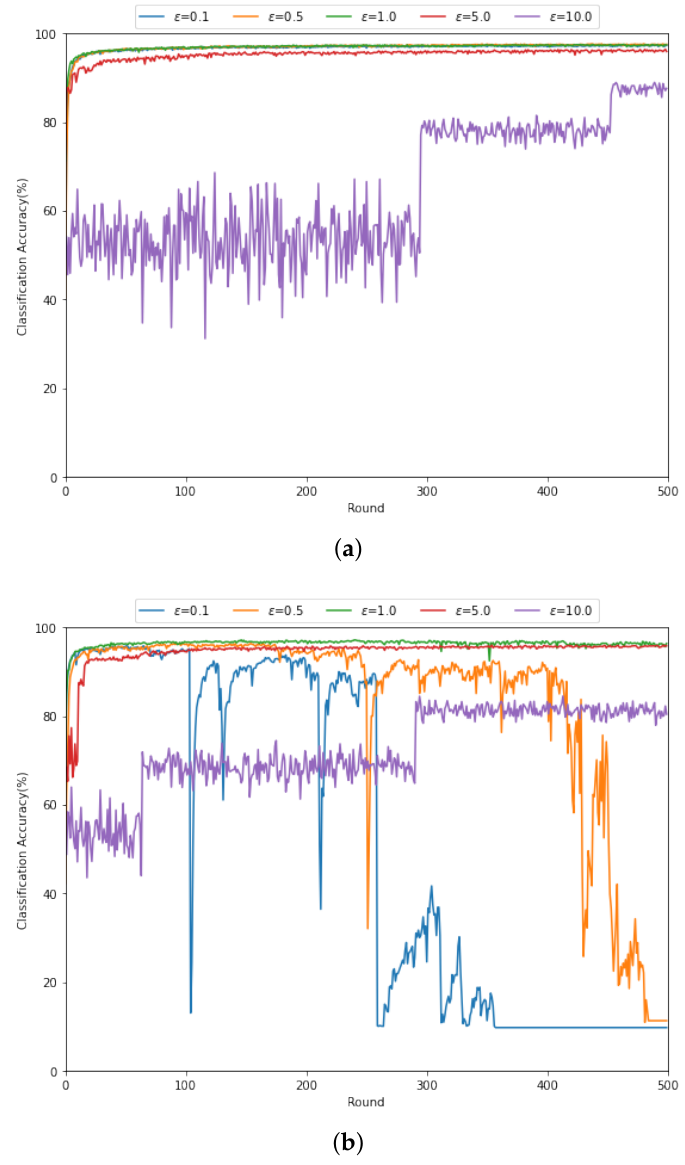
Figure 5. Classification accuracy according to various threshold levels when the updating method with MRC and thresholding in Section 4.2.2 are exploited for ( a ) SNR rec = 15 dB and ( b ) SNR rec = − 10